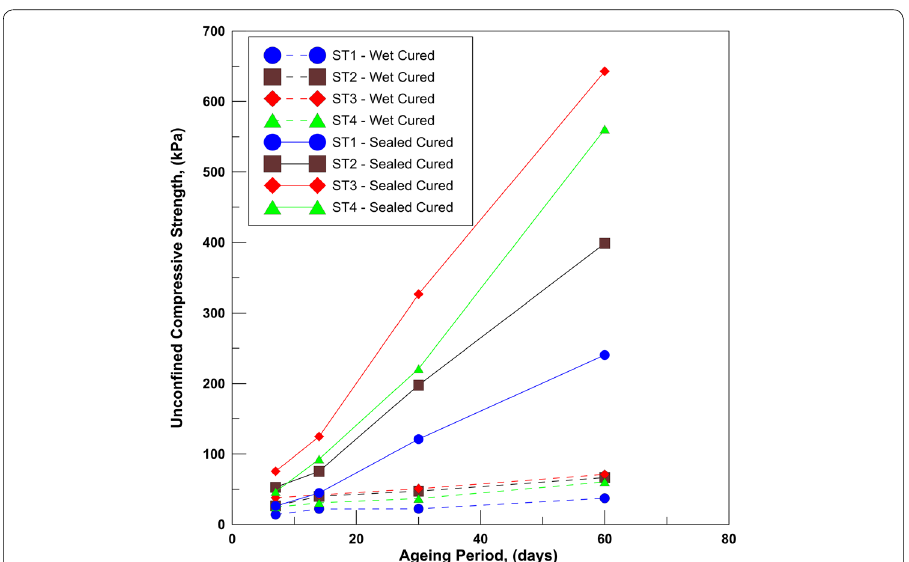
Fig. 7 Unconfined compressive strength versus ageing periods for all dosages of enzyme used in this